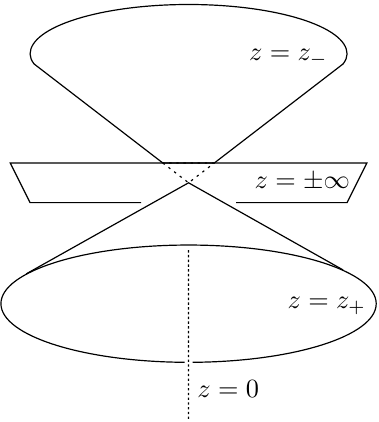
Figure 1 . Schematic structure of the geometry of a non-trivial self-similar metric, with singular loci of the ( z; t ) chart